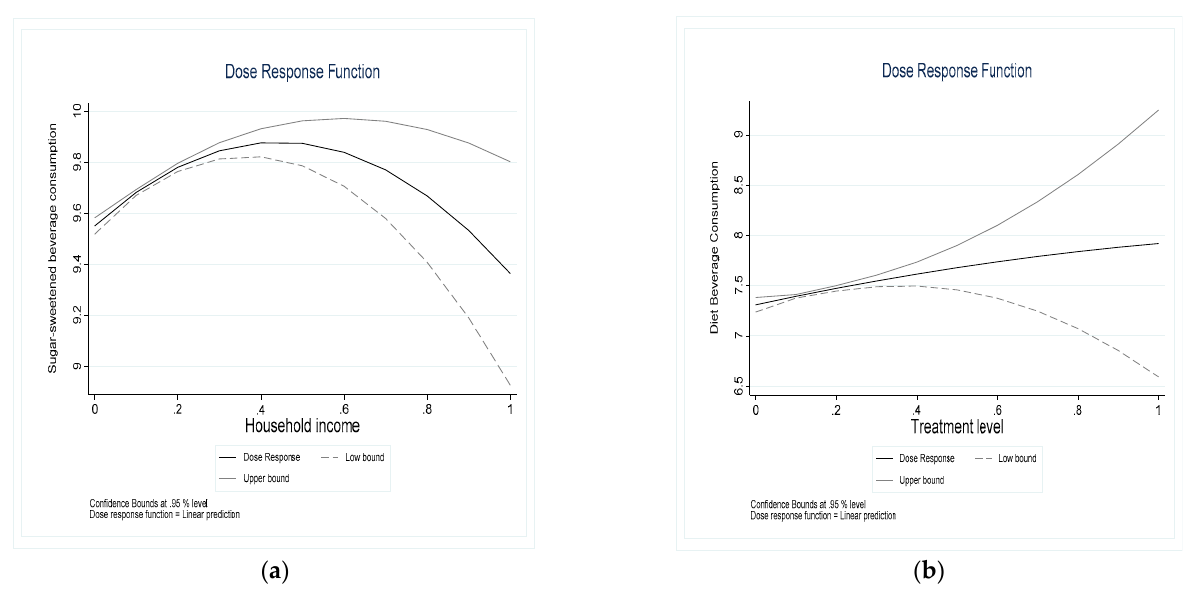
Figure 3. “Dose response” function of different household incomes on household beverage con- sumption. ( a ): A “dose-response” function of household income and household consumption of sugary drinks; ( b ): A “dose-response” function of household income and household consumption of sugar-free